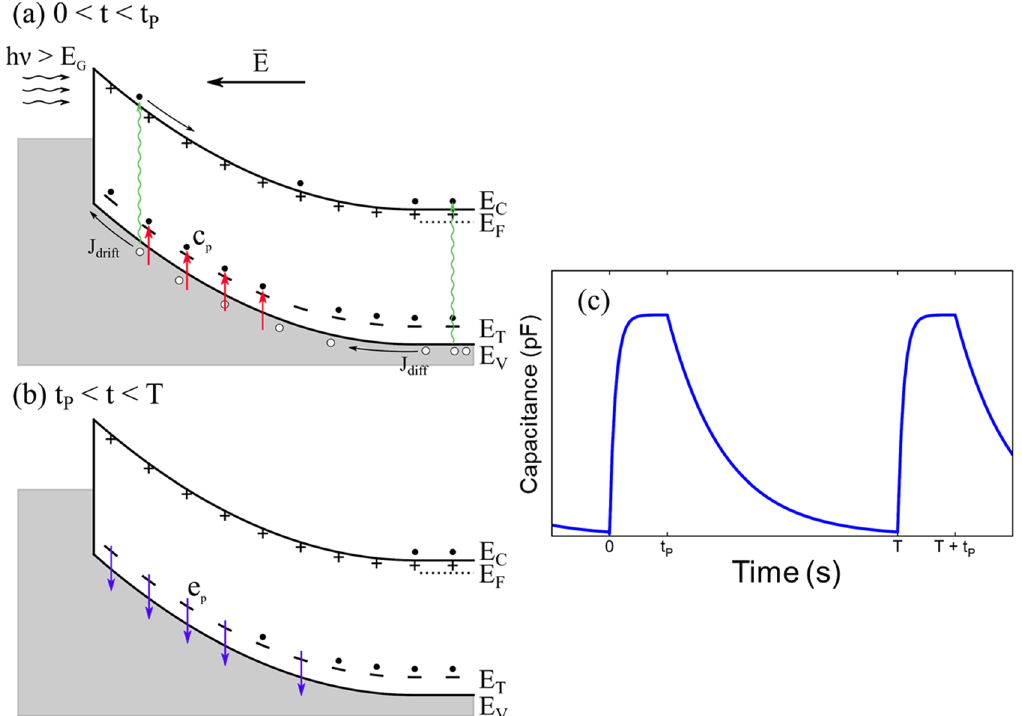
Figure 3. The basic principle of minority carrier transient spectroscopy (MCTS) measurement: ( a ) capture of the minority charge carriers from the valence band to the deep level (E T ) while optical pulses are applied; ( b ) emission of the minority charge carriers from the deep level after the optical pulse; ( c ) measured capacitance transient as a function of time. Figure adapted from Ref. [15]. Here, h ν is the energy of the optical excitation, J drift and J diff are drift and diffusion current densities, respectively, t p is the optical pulse duration, e p is the hole emission rate, and c p is the hole capture rate.